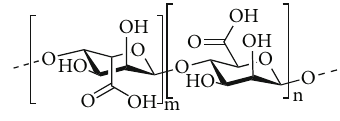
Figure 19: Chemical structure of alginic